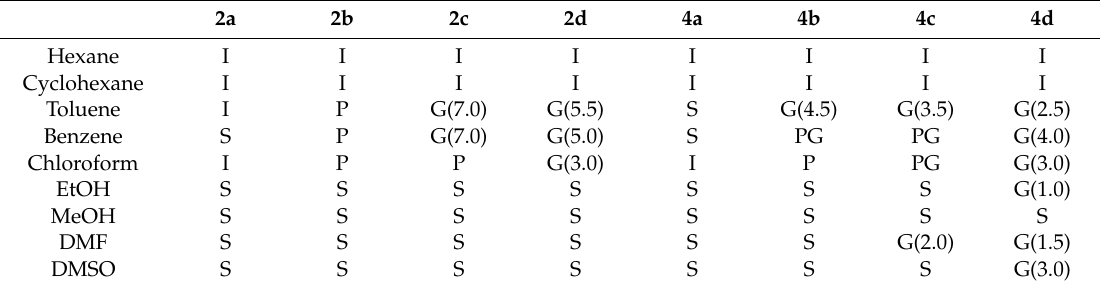
Table 1. Gelation properties of catechol derivatives in various solvents a .